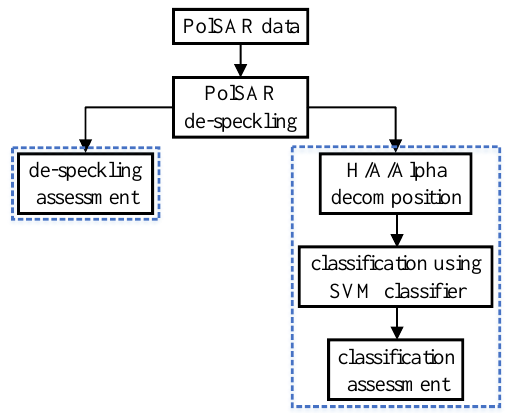
Figure 1. The workflow of this